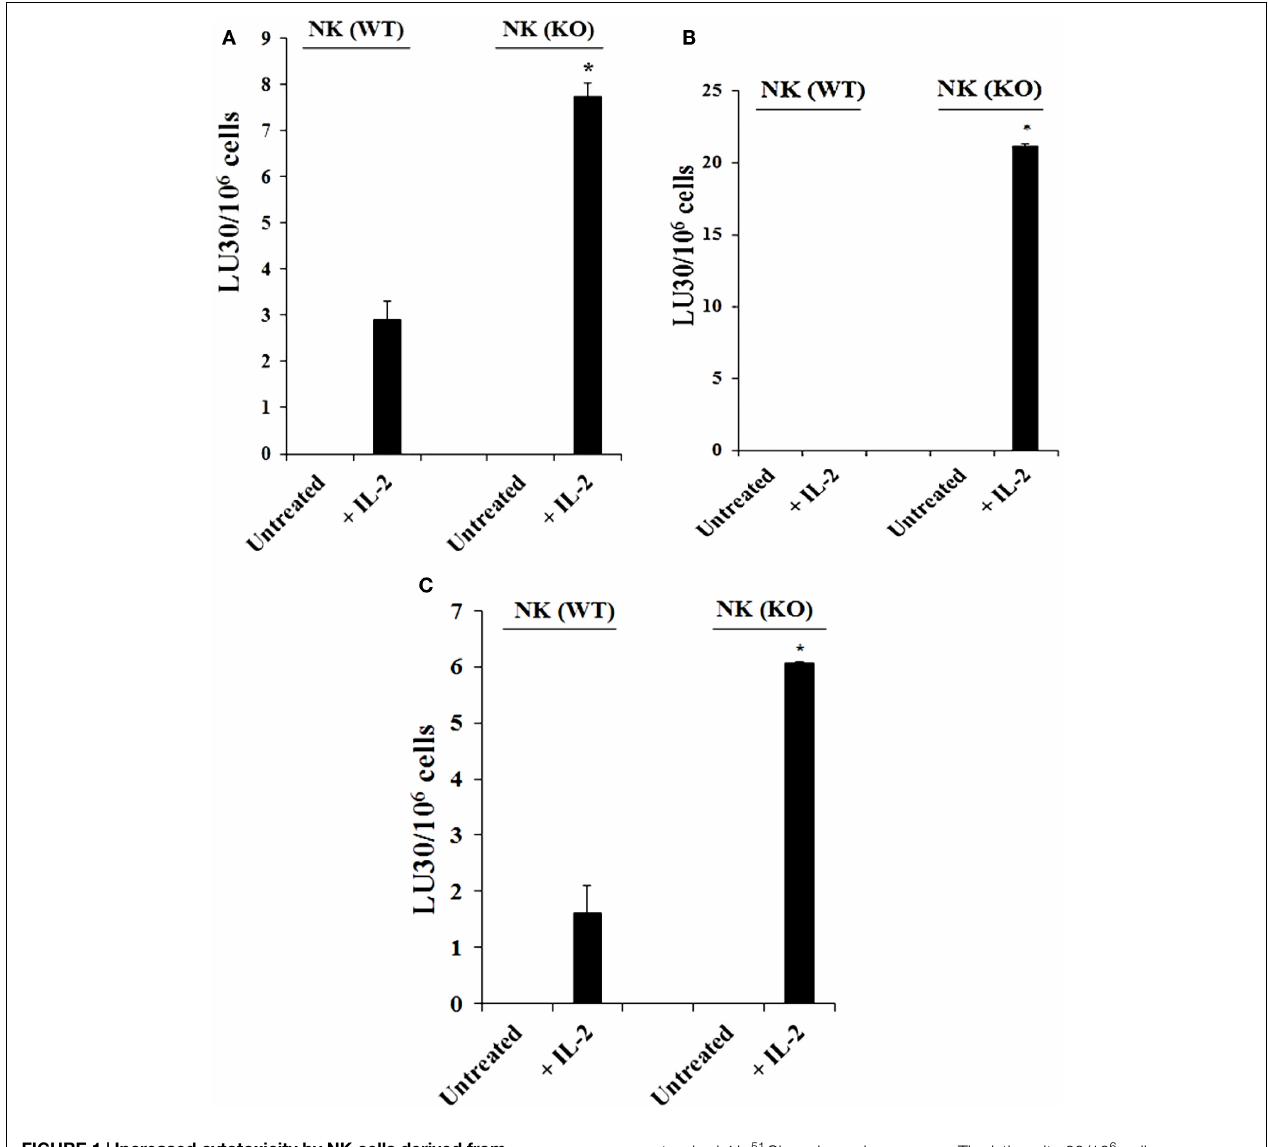
standard 4h 51 Chromium release assay. The lytic units 30/10 6 cells were determined using inverse number of NK cells required to lyse 30% of the target cells (cid:2) 100. * P < 0.05 was obtained for the difference between control WT Cox-2 flox/flox; LysM Cre/ + NK cell cytotoxicity against YAC-1 cells, MEFs, or ST63. One of several representative experiments is shown in this